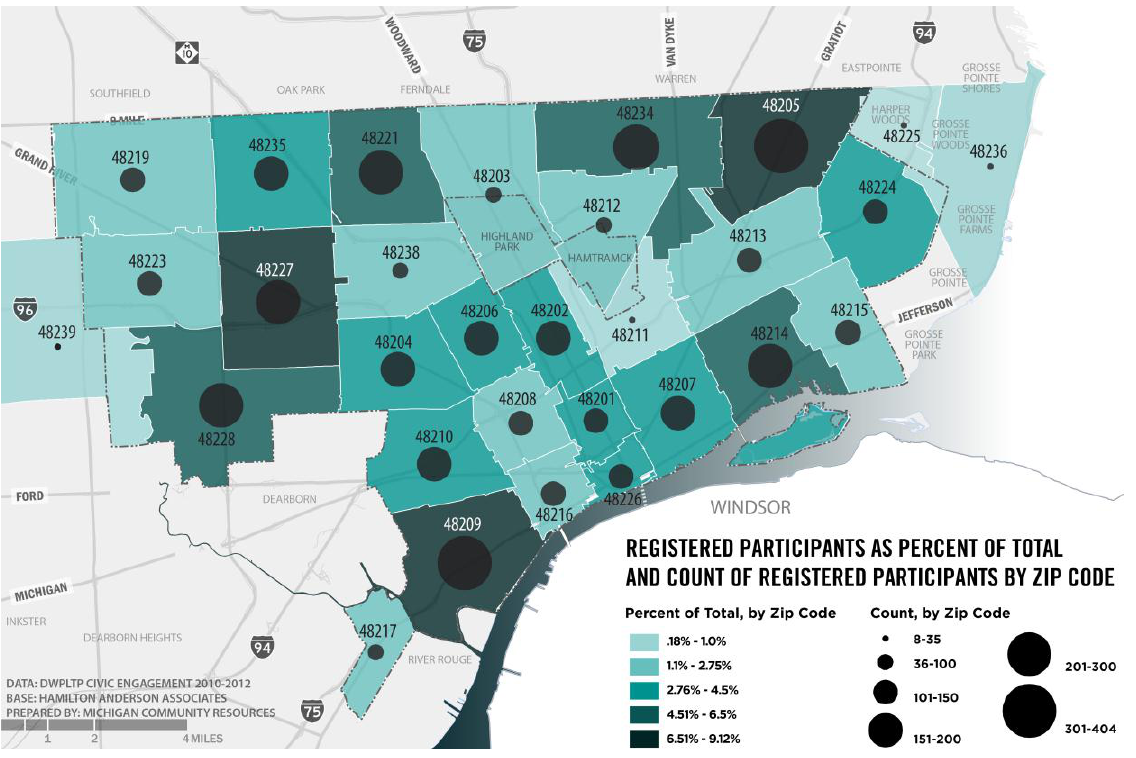
Figure 4. Map of registered participants by zip code. (Image credit: Detroit Future City: Civic Engagement